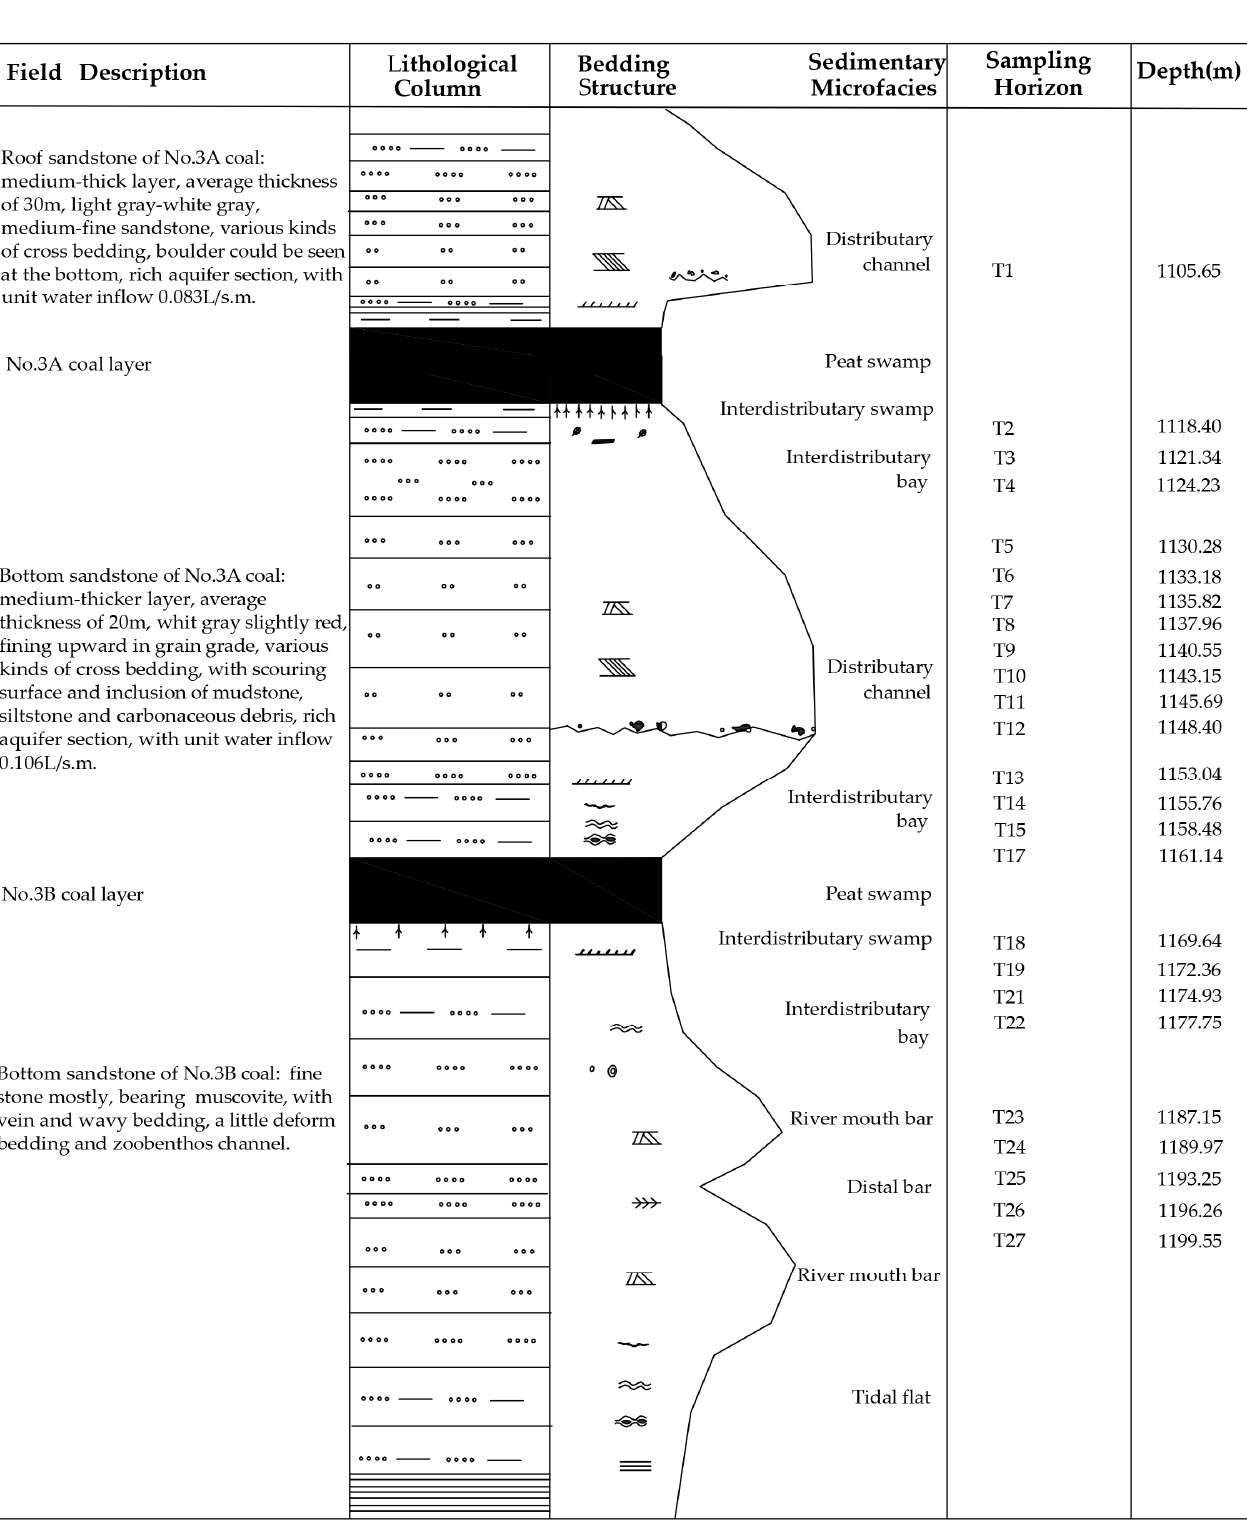
Figure A5. The sampling horizon and depth of the Shanxi Formation sandstone at No. 8 mining area of the Anju coal mine, the Southwest Shandong coalfield, China.